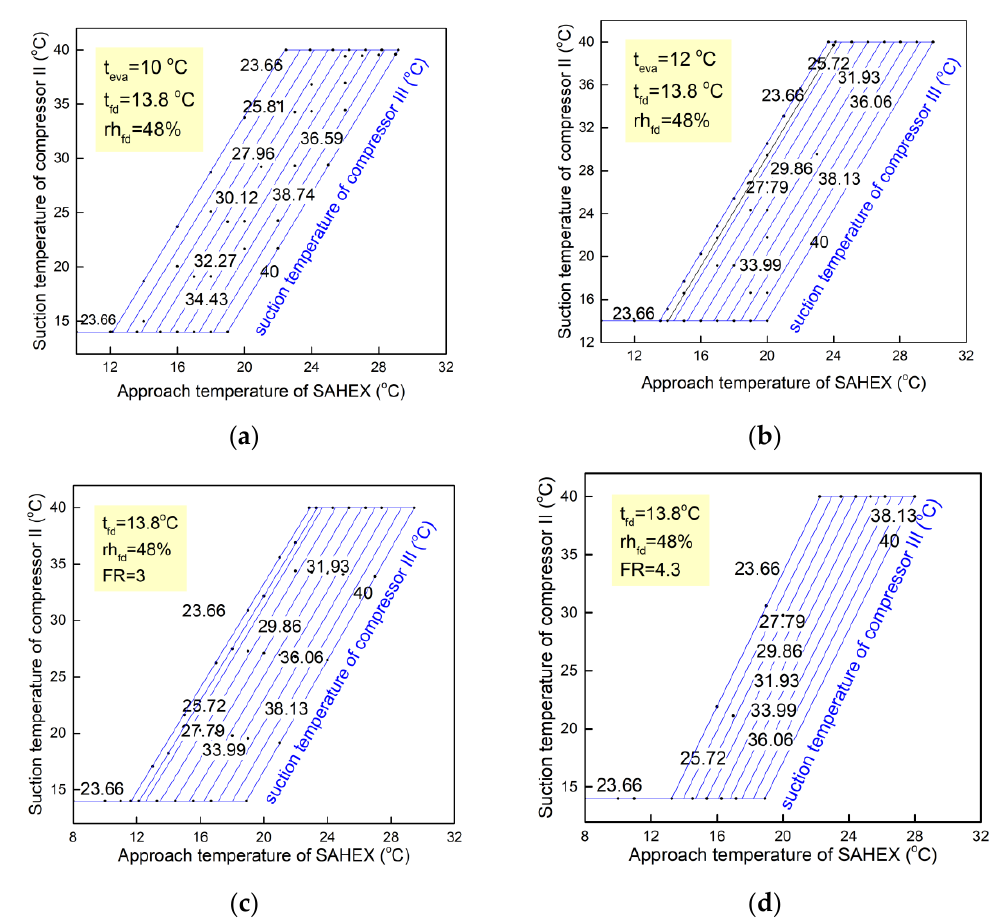
Figure 6. Optimization of suction temperatures of compressors under different working conditions: ◦ C, FR ( a ) T eva = 10 °C, FR s-a = 2.3; ( b ) T eva = 12 °C, FR s-a =2.3; ( c ) T eva = 12 °C, FR s-a =3; ( d ) T eva = 12 °C, FR s-a = 4.3. ( a ) T eva = 10 s-a = 2.3; ( b ) T eva = 12 FR s-a =